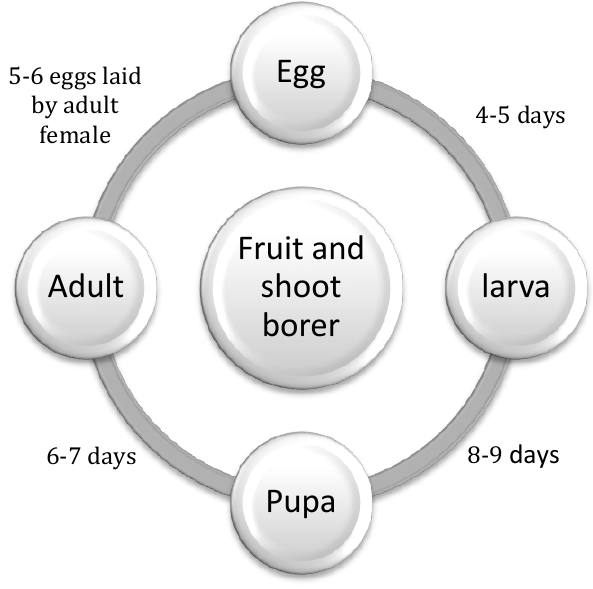
Figure 1: Lifecycle of Fruit and shoot